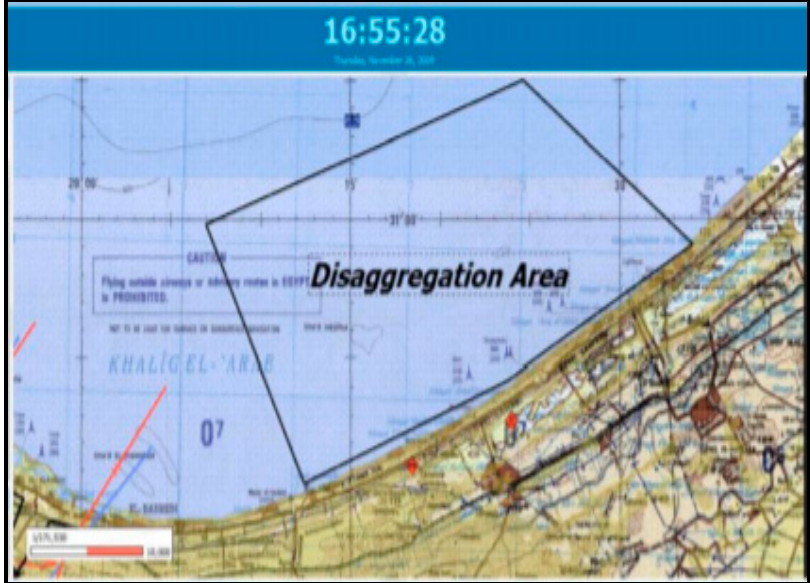
Figure 14. How to set the geographical trigger (with a polygon) in MASA Sword.